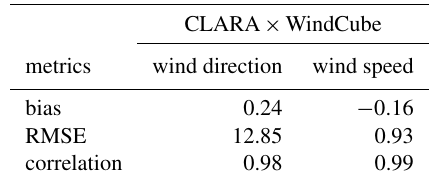
Table 7. Statistical metrics of the intercomparison between CLARA and WindCube observations. RMSE stands for root mean square error. The bias and RMSE are in ms − 1 and degrees for the wind speed and wind direction, respectively.